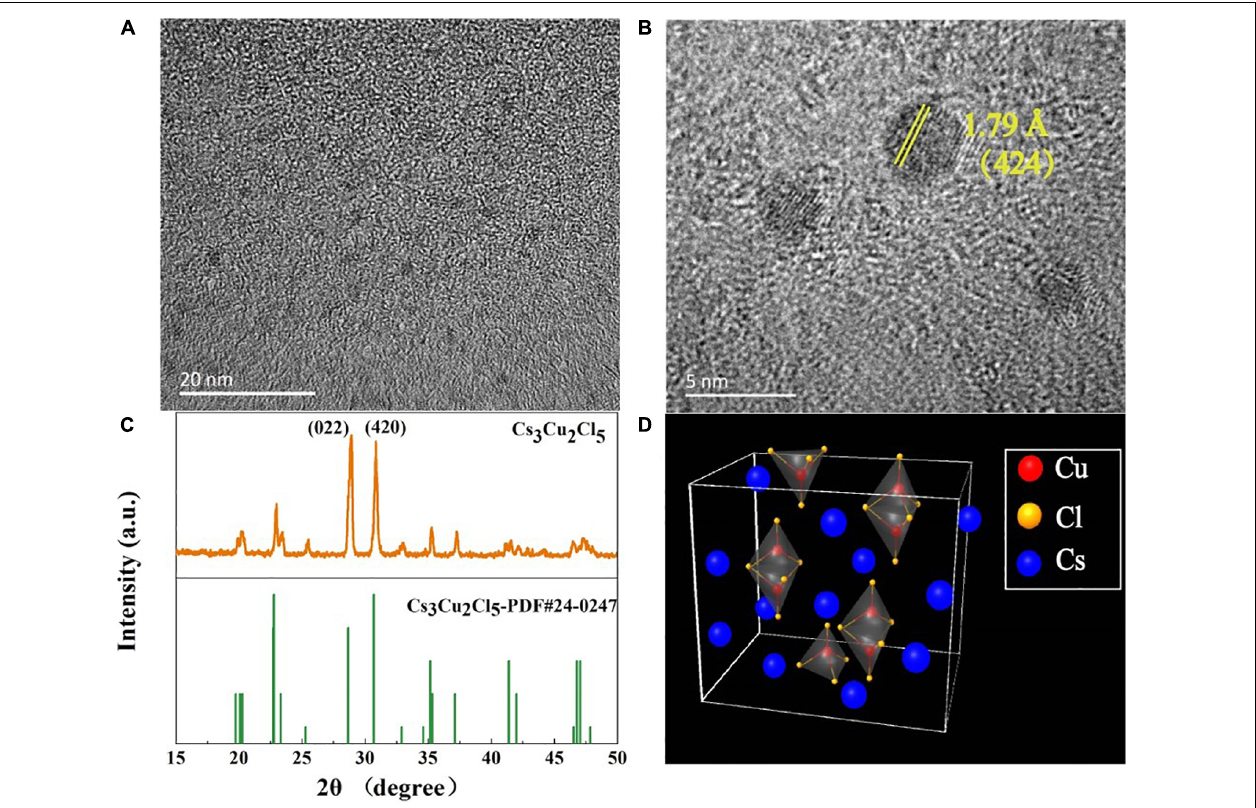
FIGURE 1 | (A) TEM image of Cs 3 Cu 2 Cl 5 NCs. (B) HRTEM image of Cs 3 Cu 2 Cl 5 NCs. (C) XRD pattern of Cs 3 Cu 2 Cl 5 NCs. (D) Crystal structure of Cs 3 Cu 2 Cl 5